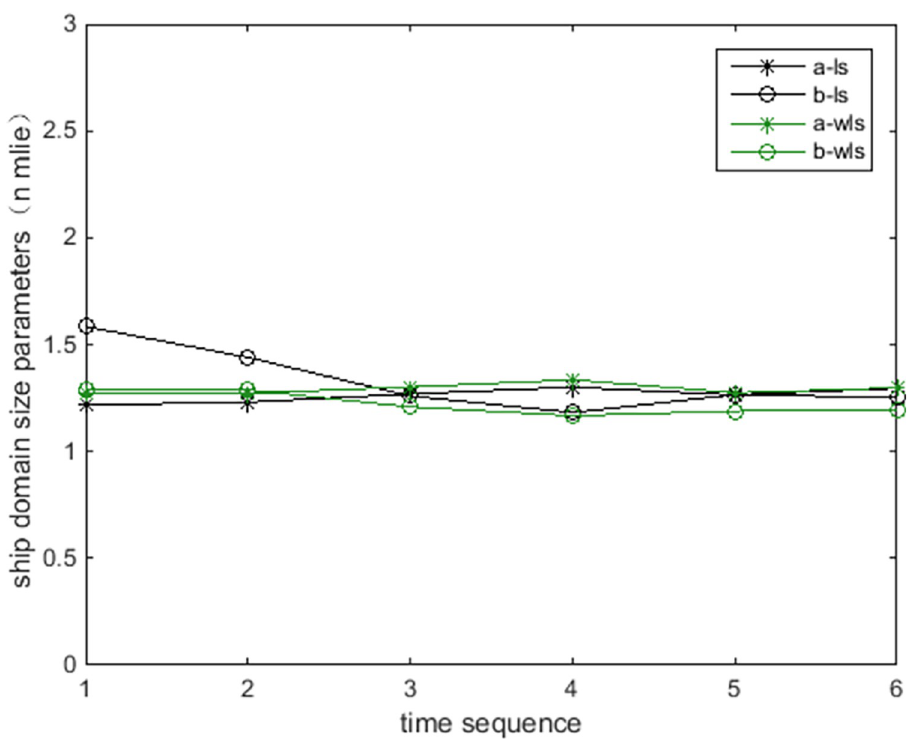
Fig 15. Long and short axes of ship domains by